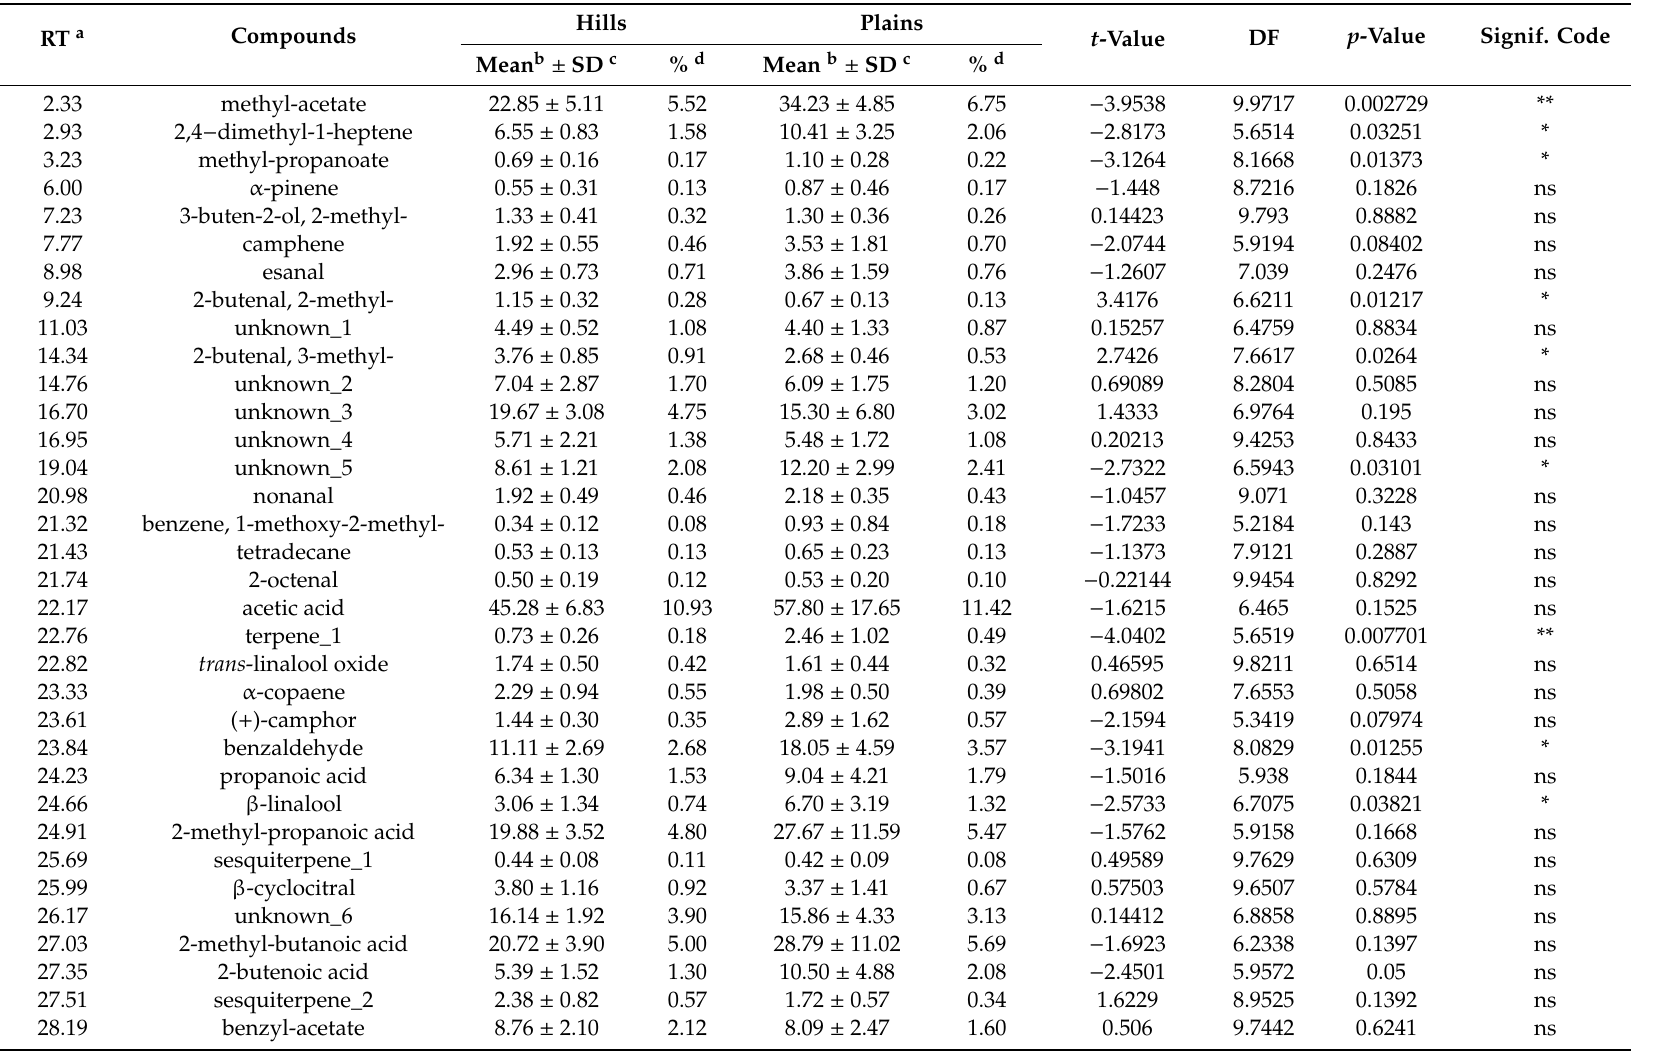
Table 3. Volatile compounds identified in raw propolis samples from hills (Ligurian–Piedmont Apennines) and plains (Po